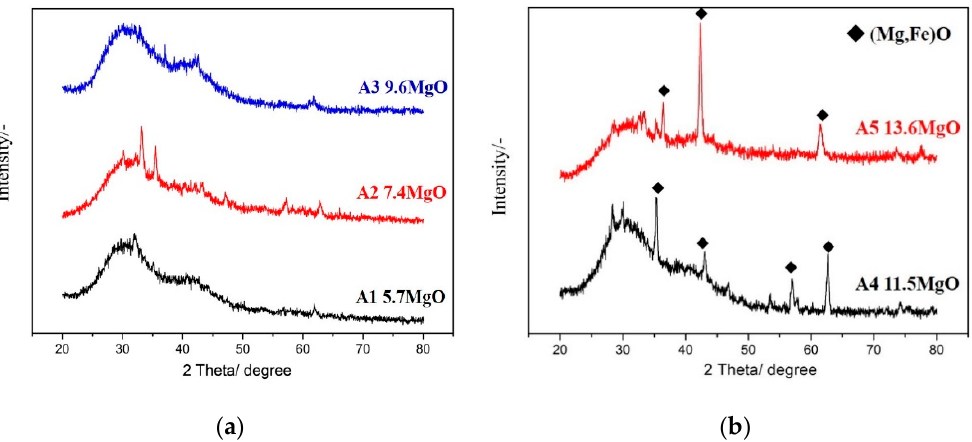
Figure 4. Amorphous glass phases of the samples ( a ) A1–A3 produced by water quenching; ( b ) A4 and A5 produced by water quenching still contain solid fractions.